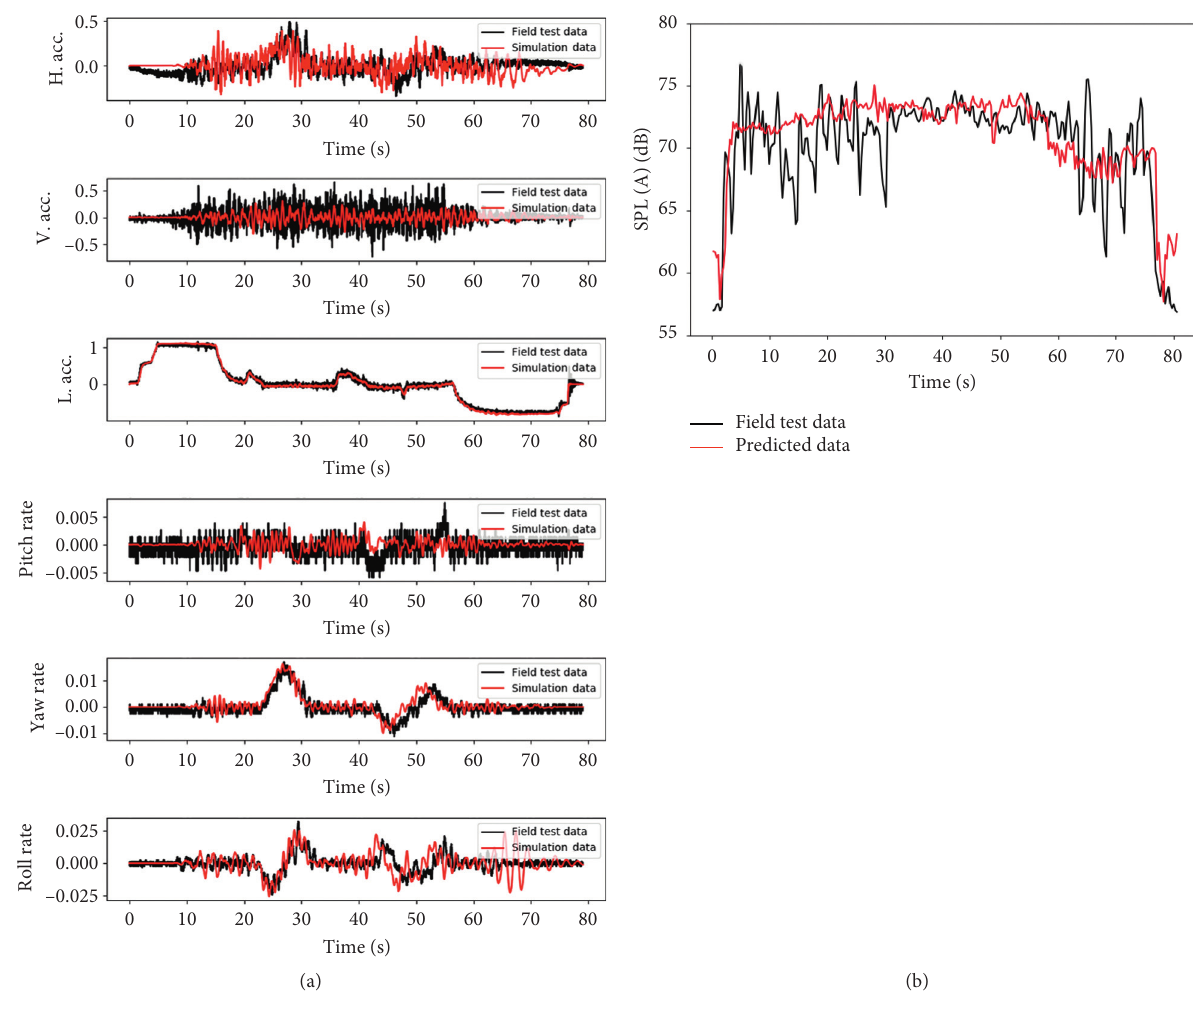
Figure 7: Verification of the VTCDM and interior noise prediction model.